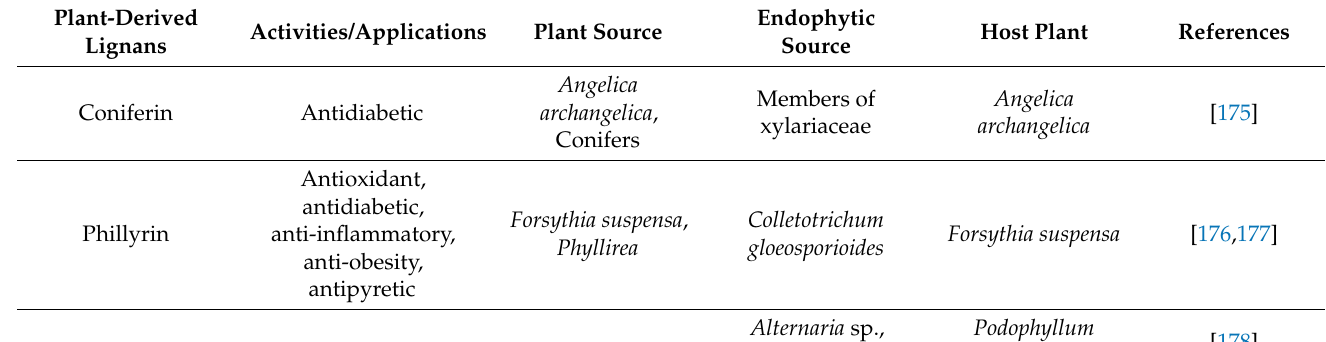
Table 4. Plant-derived lignans produced by endophytic